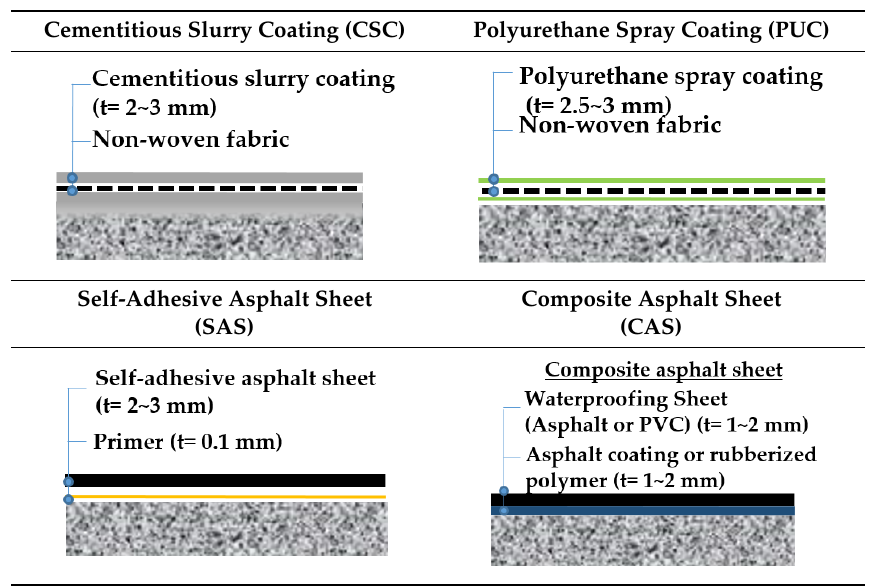
Table 5. Types of waterproofing membranes evaluated.